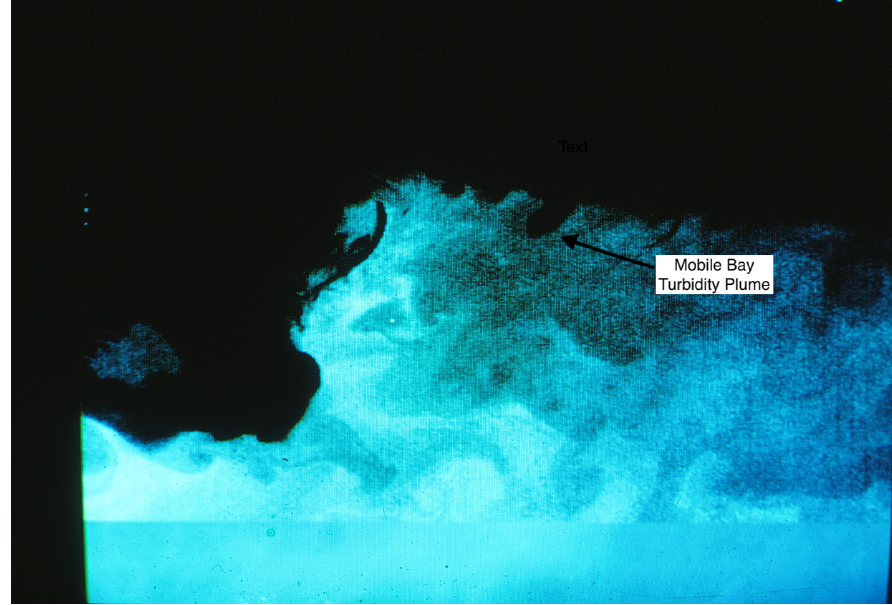
Figure 12. A sub-scene of the CZCS image from Orbit 130 (Figure 3) as atmospheric correction of the 443 nm band of CZCS takes place. The area is the Mississippi Delta (left center) and a portion of the Gulf of Mexico (lower half). The top 5/6 of the image is corrected. The bottom 1/6 of the image is uncorrected. The area indicated as the “Mobile Bay Turbidity Plume” has zero (or negative) radiance after correction because ρ w ( 670 ) is significantly greater than zero in the plume. Atmospheric correction was based on L w ( λ ) measurements made from the R.V. Athena II at a position near the upper left of the “Mobile Bay Turbidity Plume” insert (29 ◦ 57 (cid:48) N and 87 ◦ 57 (cid:48)